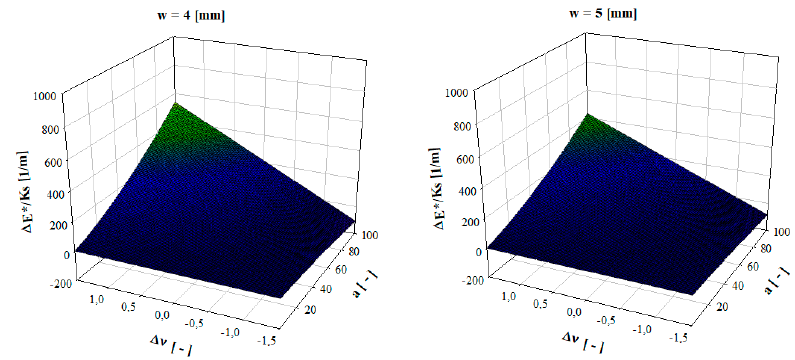
Figure 3. Plotting of complex modulus variation as a function of specimen dimensions, stiffness, and Poisson’s ratio variation.